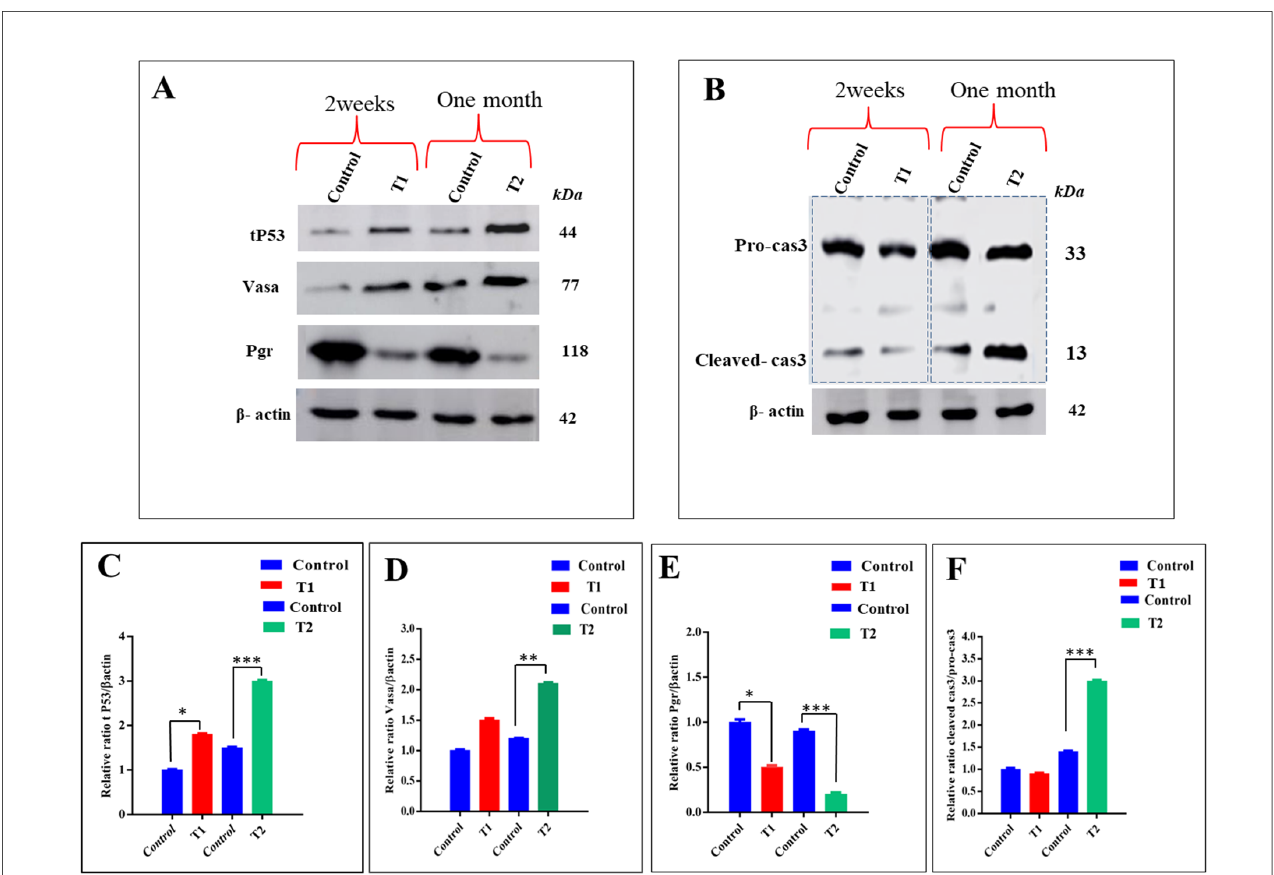
Figure 8. Effect of ZnO-NPs on necroptosis via mutated tP53 formation: ( A ) Western blot analysis of the tP53 protein, Vasa protein, and Pgr protein normalized to β -actin in control, T1, and T2 groups. ( B ) Western blot analysis of procaspase-3 and cleaved caspase-3 in the control, T1, and T2 groups revealed the overexpression of cleaved caspase-3 in T2 compared with the control and T1 groups. ( C – F ) Quantified protein expression revealed the ratio analysis of tP53/ β -actin, Vasa/ β -actin, Pgr/ β - actin, and cleaved -cas3/pro-cas3, respectively quantified by the Image J software. Data expressed as mean ± SEM. * p < 0.05, ** p < 0.01, and *** p < 0.001. T1 = group was exposed to 1/5th of the estimated LC 50 of ZnO-NPs in water daily for two weeks (15 days). T2 = group was exposed to